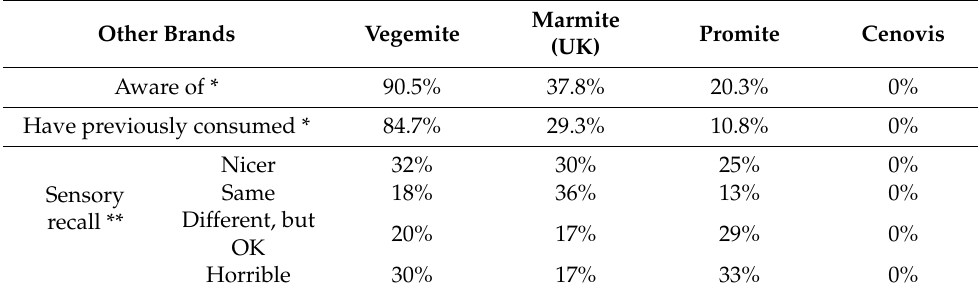
Table 6. Awareness and consumption of other (national) yeast spreads brands in New Zealand ( n = 222). Marmite Promite Cenovis Other Brands Vegemite (UK) Aware of * 90.5% 37.8% 20.3% 0% Have previously consumed * 84.7% 29.3% 10.8% 0%